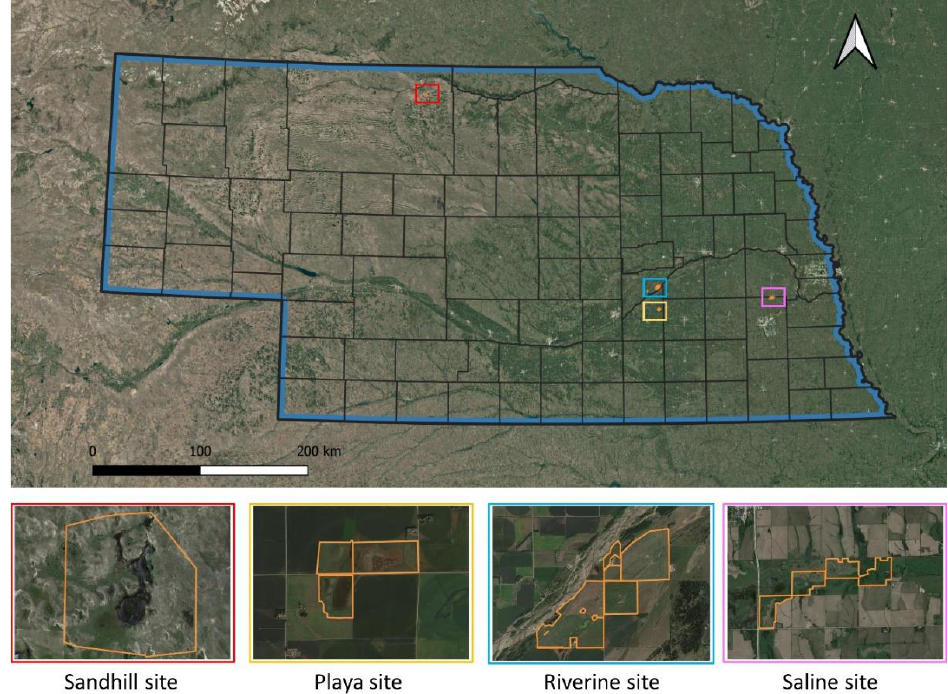
Figure 6. Location of the four case study sites. The sandhill site (red box) is located in Cherry County in northern Nebraska; the playa site (yellow box) is located in Hamilton County in the Rainwater Basin; the riverine site (blue box) is located in Merrick County in the Rainwater Basin; the saline site (pink box) is located in Lancaster County in eastern Nebraska.